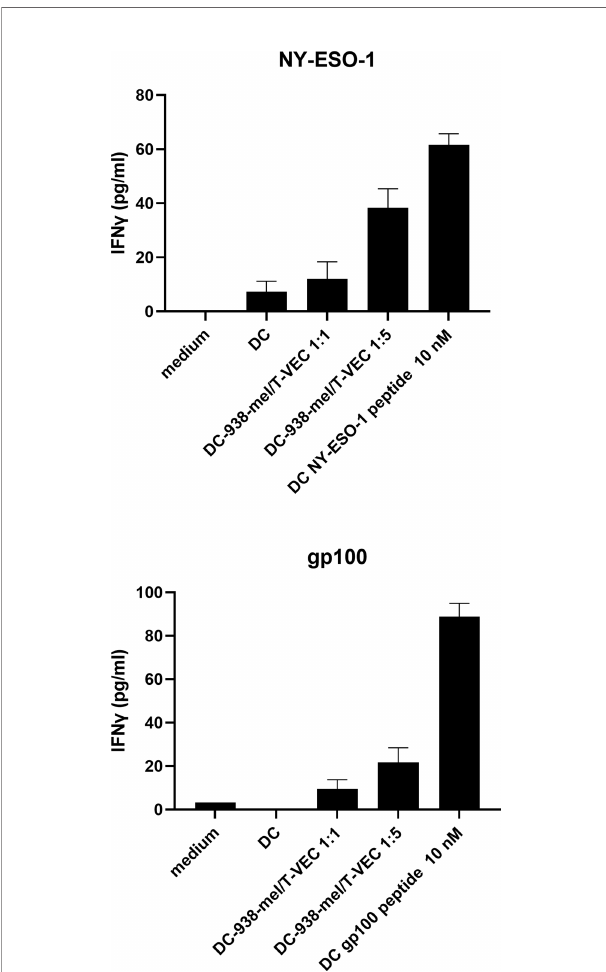
FIGURE 5 | Antigen presentation by BDCA-1 + /BDCA-3 + myDC that have taken up T-VEC-treated melanoma cells. 938-mel cells were treated with T-VEC at a MOI of 1 for 24h and subsequently co-cultured with BDCA-1 + / BDCA-3 + myDC from an HLA-A2 + donor for 24h. After 24h, cells were harvested and counted and put into co-culture (1:1) with autologous T cells that were electroporated with mRNA encoding for the a - and b -chain of the TCR for NY-ESO-1 (top panel) or gp100 (bottom panel). After overnight co- culture of DC and TCR-transfected T cells, the supernatant was harvested and analyzed for IFN- g content by ELISA. Data points depict the mean ± SD of 3 replicate